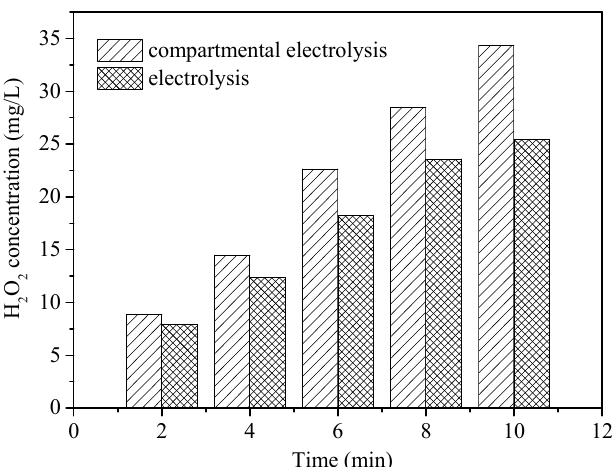
Figure 7. H 2 O 2 generation in the electrolysis and compartmental electrolysis (cathode chamber) systems (O 2 flow rate = 0.2 L/min; Applied current = 20 mA/cm 2 ; Temperature = 25 ± 2 °C).